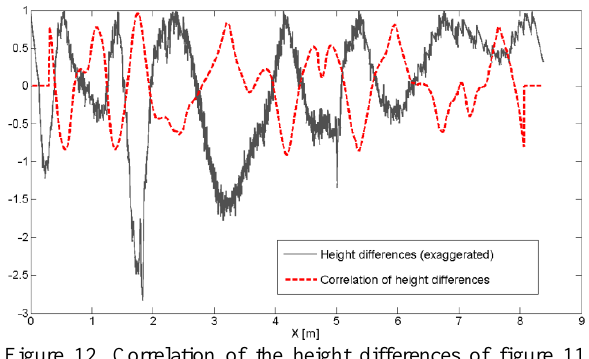
Figure 12. Correlation of the height differences of figure 11 with the template Figure 13 shows the plot of height differences between the scan lines and its fitted polynomial; they represent the most important indicator of ruts. The scan lines are selected with 1 m interval. Darker points mean higher height differences. Figure 14 represents the correlation coefficients of the height differences with respect to the template. Locations with correlation coefficient above 0.5 are visualised in blue colour.